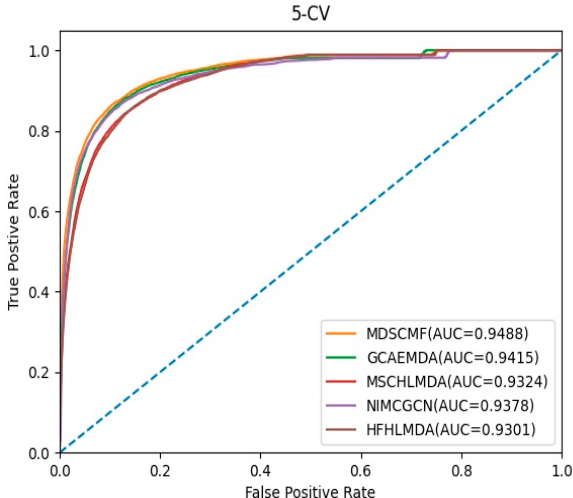
Figure 1. AUC of 5-CV compared with those of GCAEMDA, MSCHLMDA, NIMCGCN, and HFHLMDA.